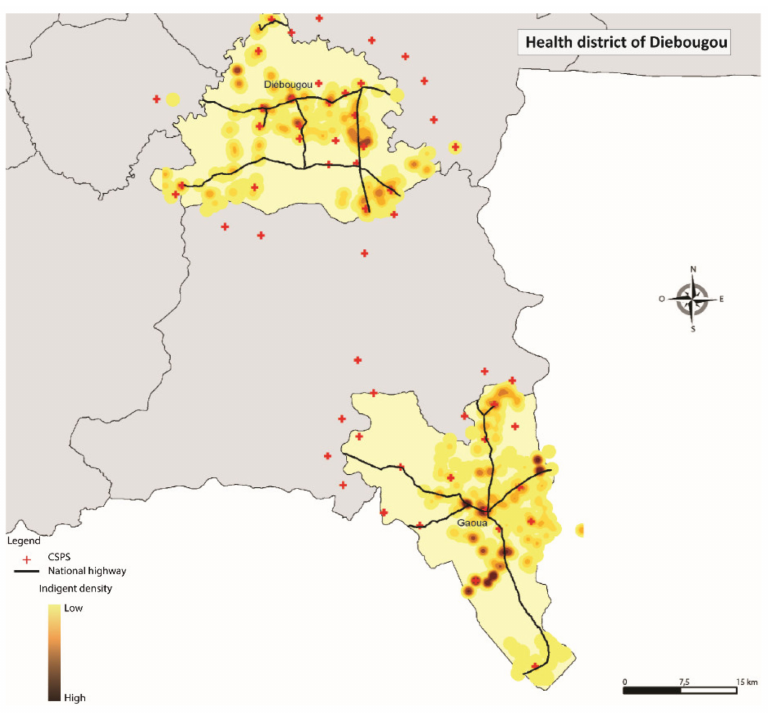
Figure 1. Geographical concentration of the respondents in Di é